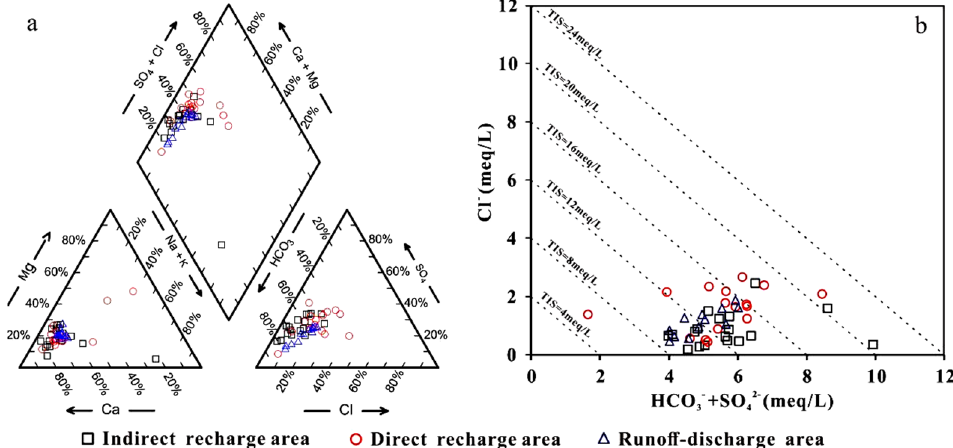
Figure 2. Piper diagram ( a ) and TIS diagram ( b ) of karst water from the Baotu Karst Spring sys- tem.